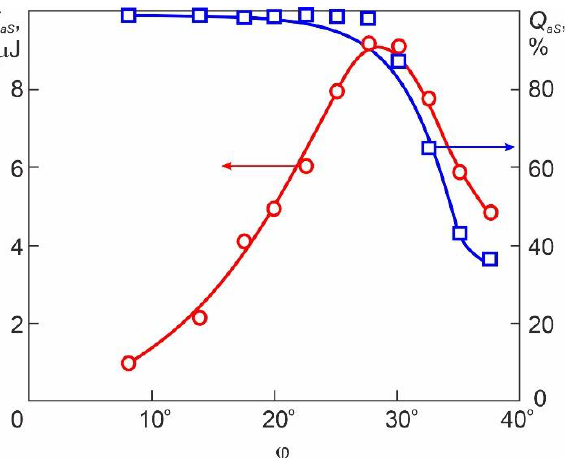
Figure 6. Dependence of the anti-Stokes pulse train energy E aS and the single anti-Stokes pulse self-separation quality Q aS on the rotation angle φ of the active CaMoO 4 element. Points are the experimental results. Lines are the modeling results.